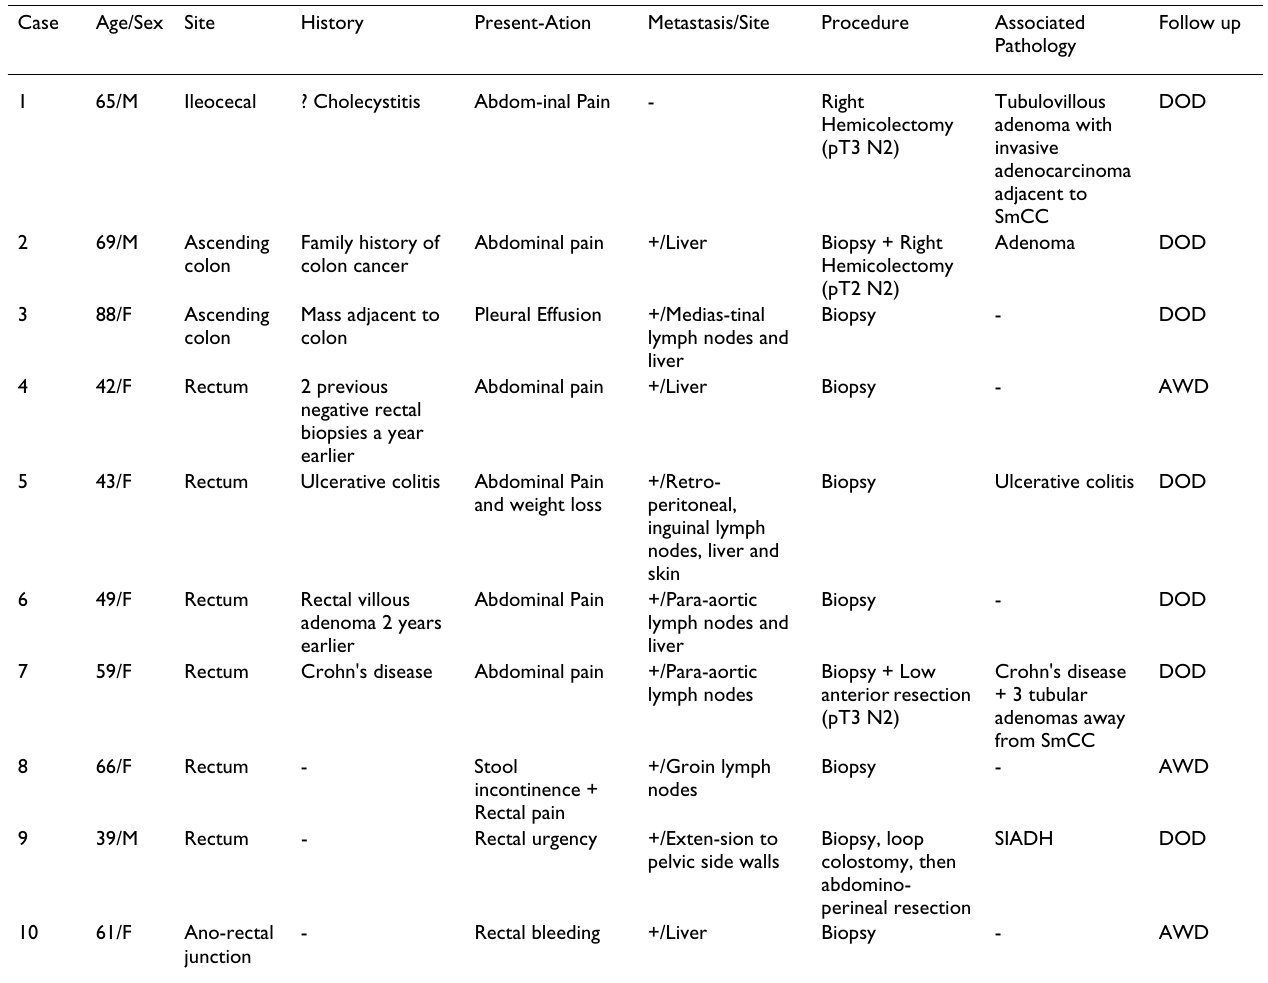
Table 2: Demographic and clinical summary